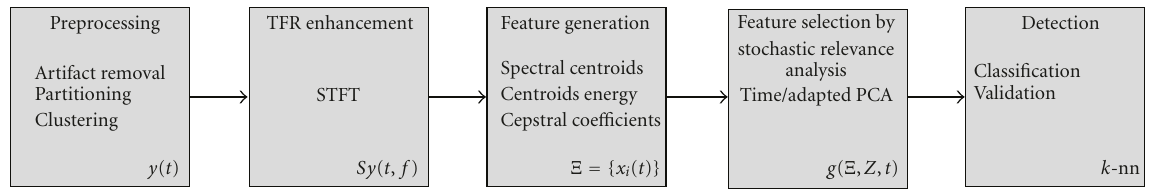
Figure 1: Schematic representation of an automated system for OSA diagnosing from t - f representation of PPG envelope.